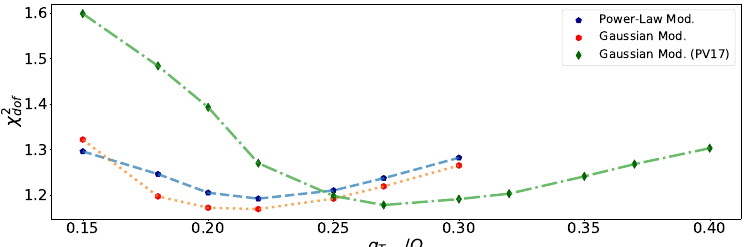
values for the fits obtained adopting the Power-Law (blue short-dashed line), the Figure 7 . χ 2 dof Gaussian (red dotted line), both with the Logarithmic g function, and the PV17 model (green K long-dashed line) with the PV17 g functional form, as a function of q . K T max /Q